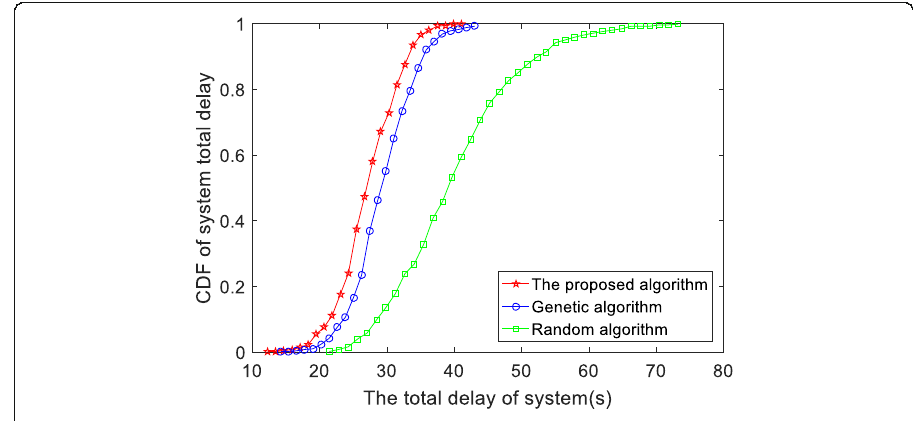
Fig. 8 CDF curves of the total system delay under different algorithms